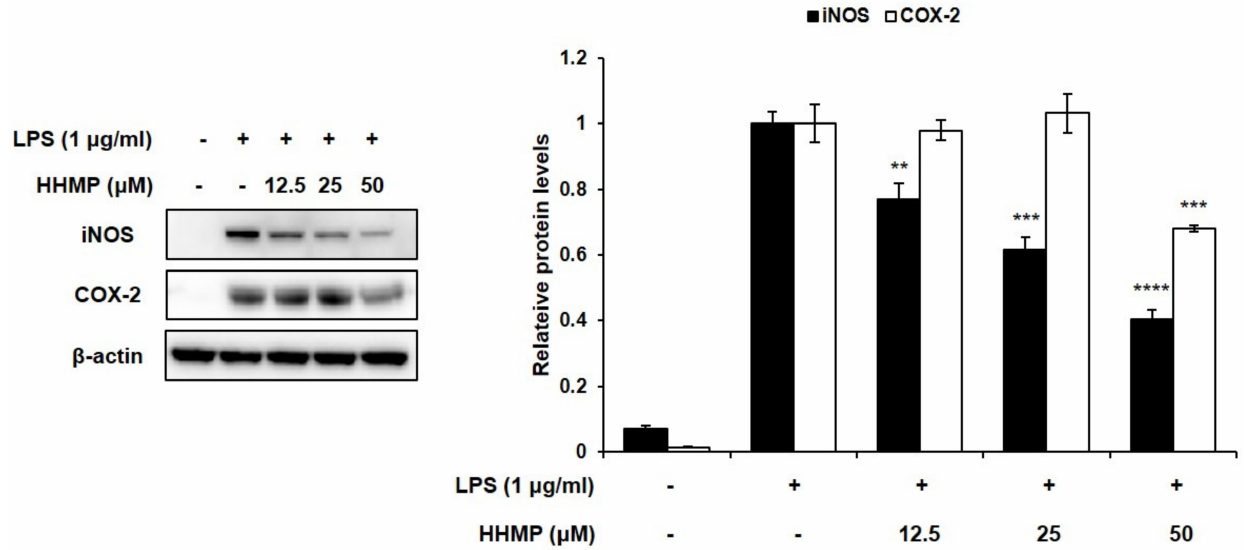
Figure 2. Effect of HHMP on the expression of inflammatory enzymes iNOS and COX-2 in LPS-stimulated RAW 264.7 cells. Cells were pre-treated with HHMP (12.5, 25, and 50 µ M) and then treated with LPS for 24 h. Protein levels were determined using Western blot analysis. +: added in the cells; -: not added in the cells. All experiments were performed in triplicate, and the results are expressed as the mean ± standard deviation (SD); * p < 0.05, ** p < 0.01, *** p < 0.001, and **** p < 0.0001 compared with the LPS-stimulated